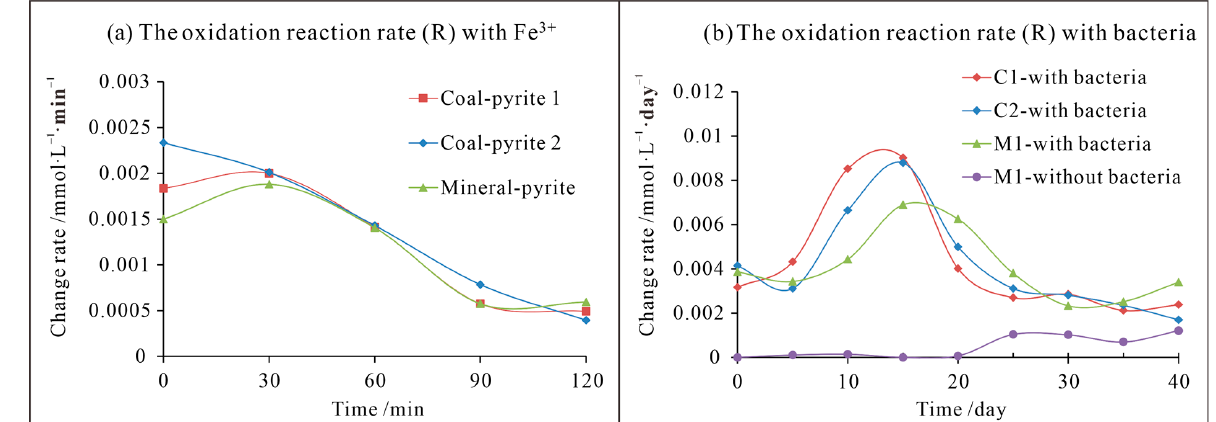
Figure 9. The oxidation rate of pyrite in different conditions of the reactions system: ( a ) is the pyrite oxidation rate ( R ) with Fe 3+ ; ( b ) is the pyrite oxidation rate ( R ) with bacteria.